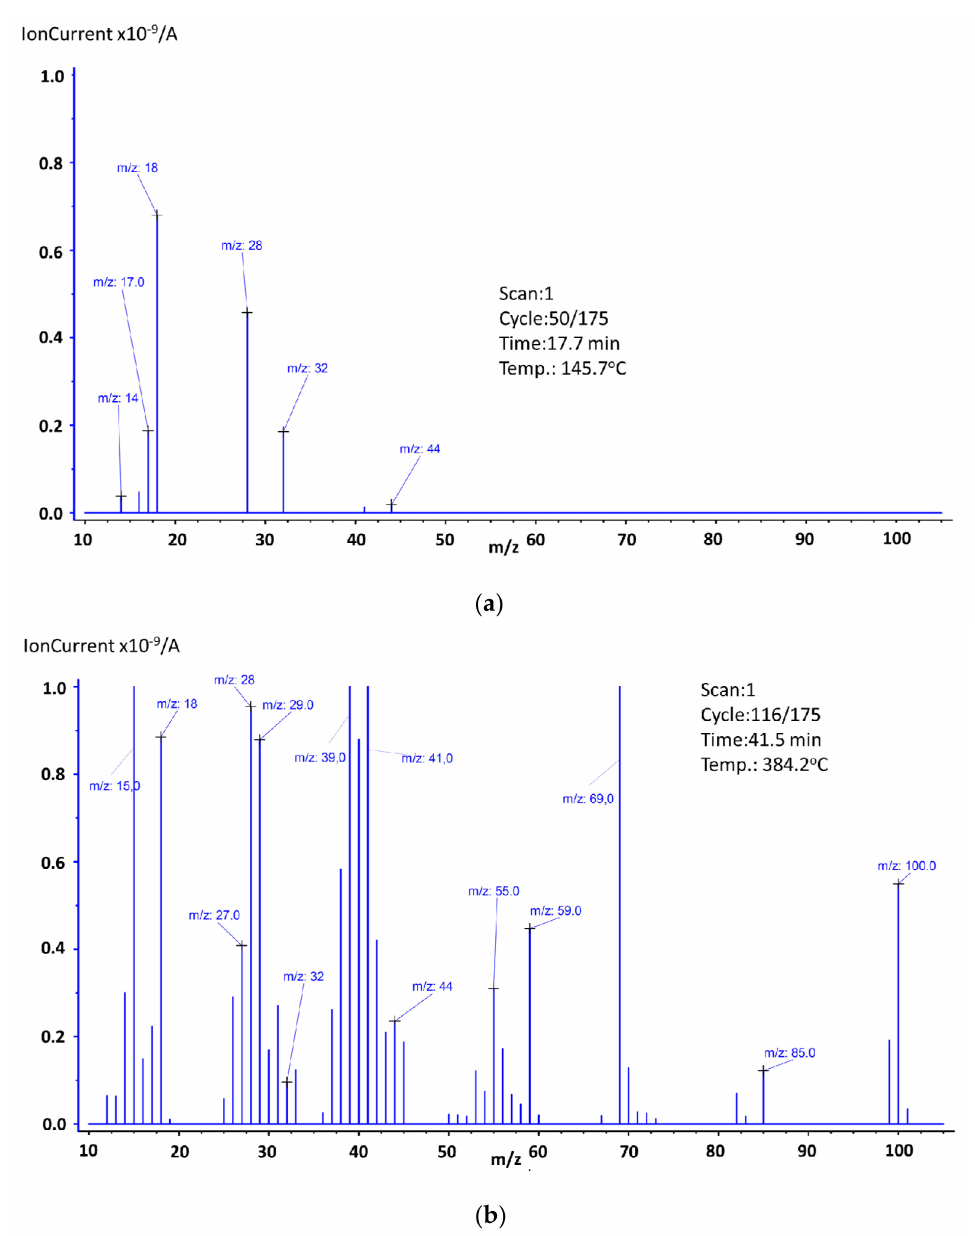
Figure 7. Mass spectra of Eu2,6DClB/PMMA at endothermic maxim: ( a ) 145.7 ◦ C, ( b ) 384.2 ◦ C. Some shifts compared to the DSC temperature value shown in Table 3 are observed because of the apparatus response